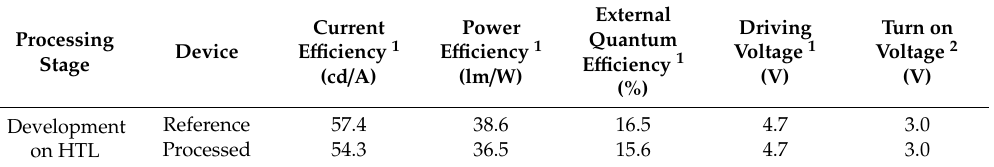
Figure 4. Comparison of the current-voltage-luminance (JVL) characteristics of the OLED patterned on the HTL (red line) and the reference (black line): ( a ) current density-voltage; ( b ) luminance-voltage; ( c ) current efficiency-luminance; ( d ) power efficiency-luminance. Table 1. Performance summary of a reference device and a develop processed device.